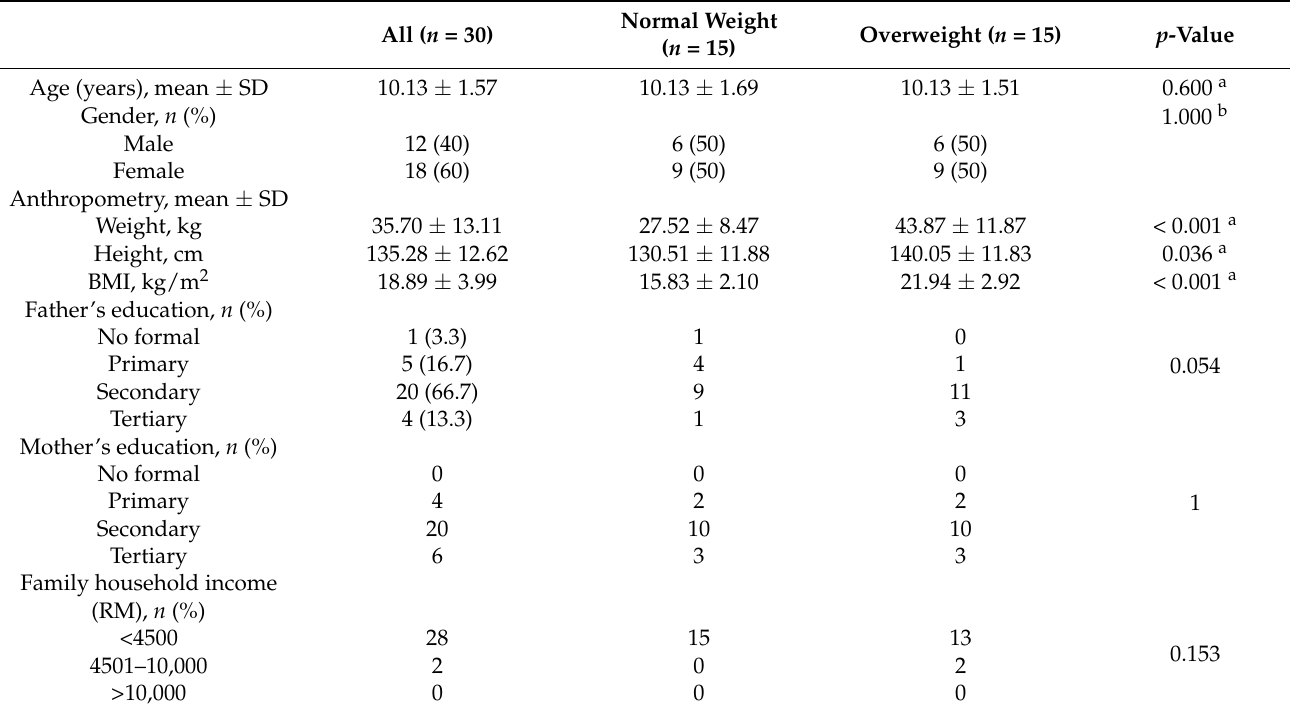
Table 1. Characteristics of the participants ( n =